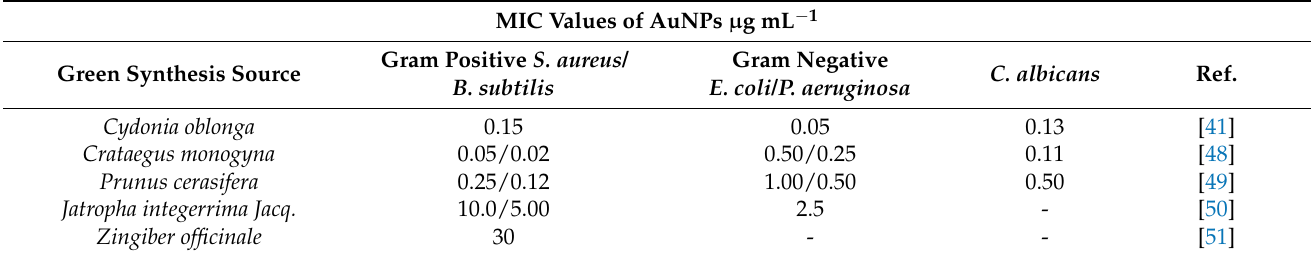
Table 4. The concentrations of AuNPs that were effective in suppressing the growth of microorgan- isms in different biologically sourced green synthesis studies.